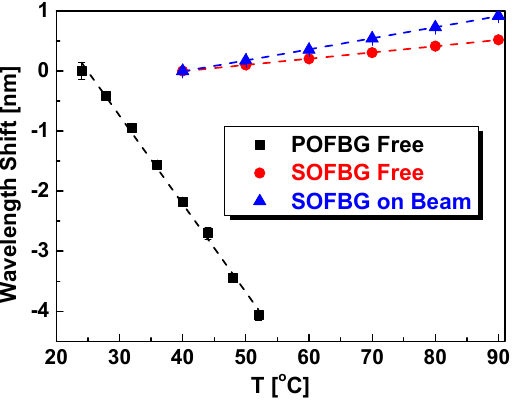
Figure 6. Bragg wavelength shift of POFBG and SOFBG vs. temperature. Table 5. The linear fitting results of thermal response of POFBG and SOFBG.